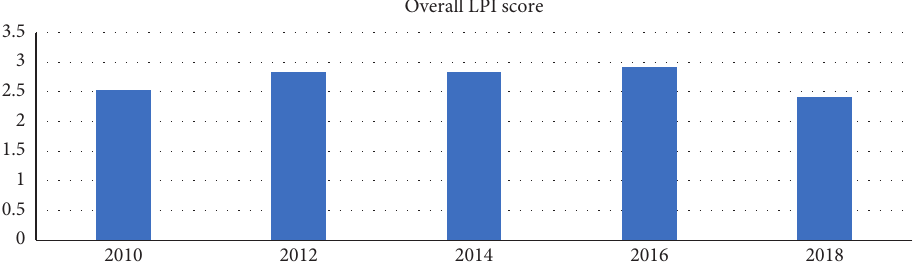
Figure 2: Logistic performance index score (1 (low) to 5 (high)) of Pakistan from 2010 to 2018. The x -axis shows the years, and the y -axis shows the LPI score (source: